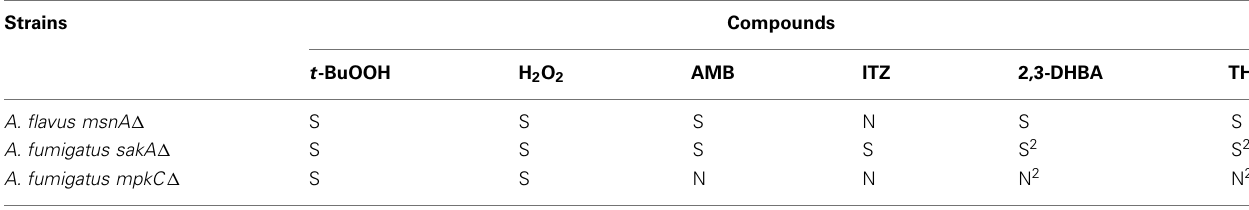
Table 2 | Summary of sensitivities of Aspergillus MAPKs ( sakA Δ , mpkC Δ ) and msnA Δ mutants to the test compounds. 1